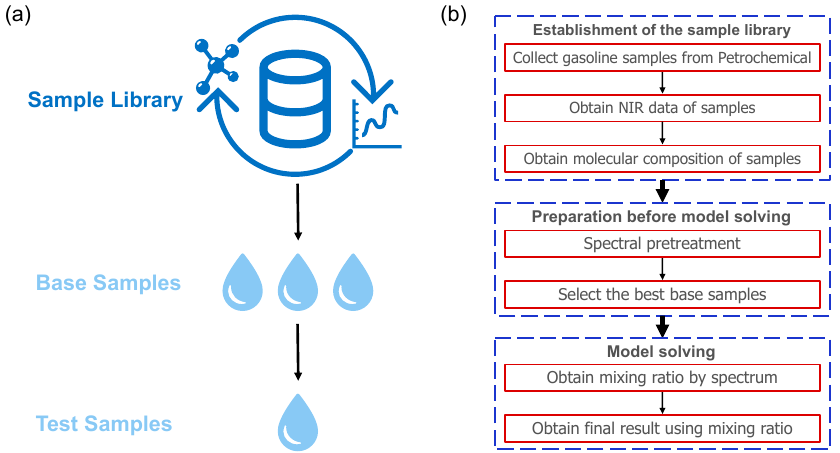
Figure 1. The diagram of predicting molecular composition from NIR spectrum. ( a ) Sample selec- tion and test sample composition prediction. ( b ) schematic diagram for the algorithm used in the model.